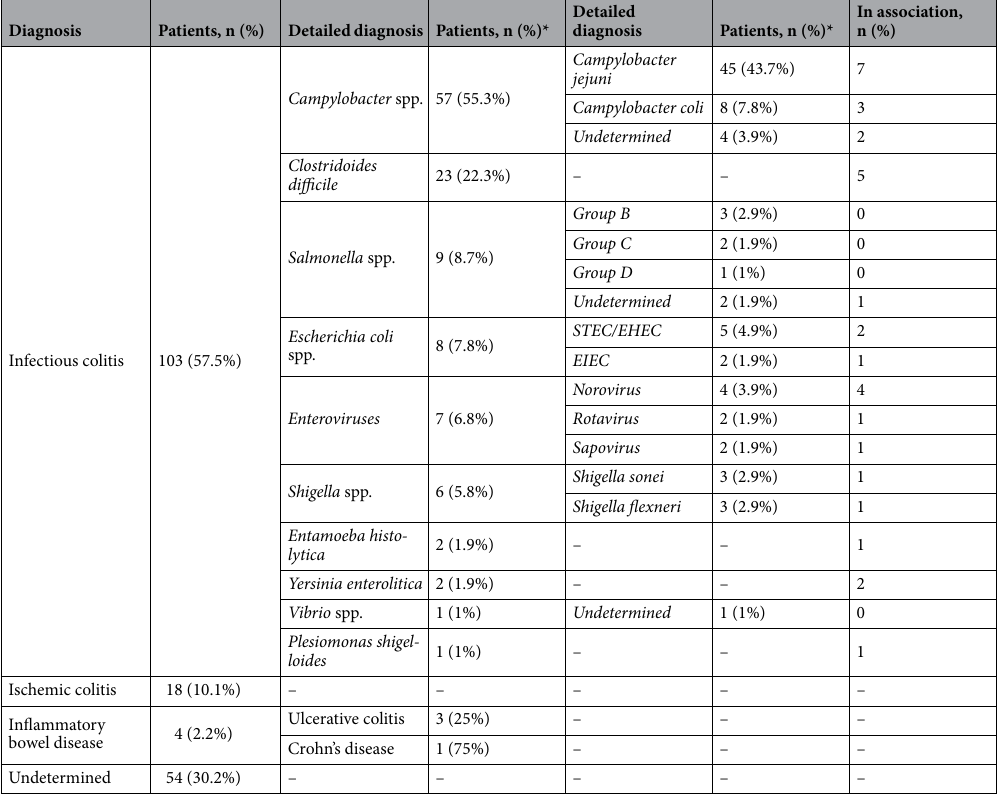
Table 4. Etiologies of acute colitis. Etiologies of acute colitis were looked for using microbiological screening of the feces (BD-Max and FilmArray GI panel) and diagnostic colonoscopy in those with negative routine PCR (BD-Max). *Proportion calculated using the main diagnosis as denominator.